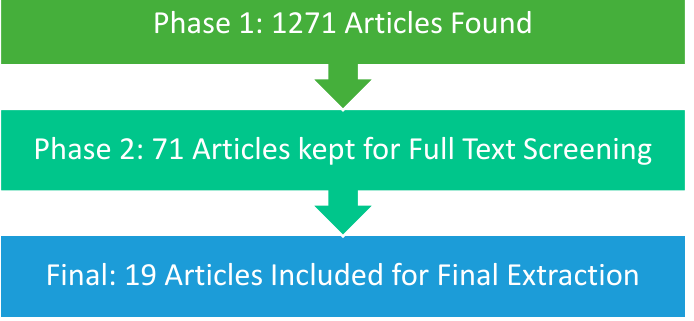
Figure 3. Flowchart of article screening.